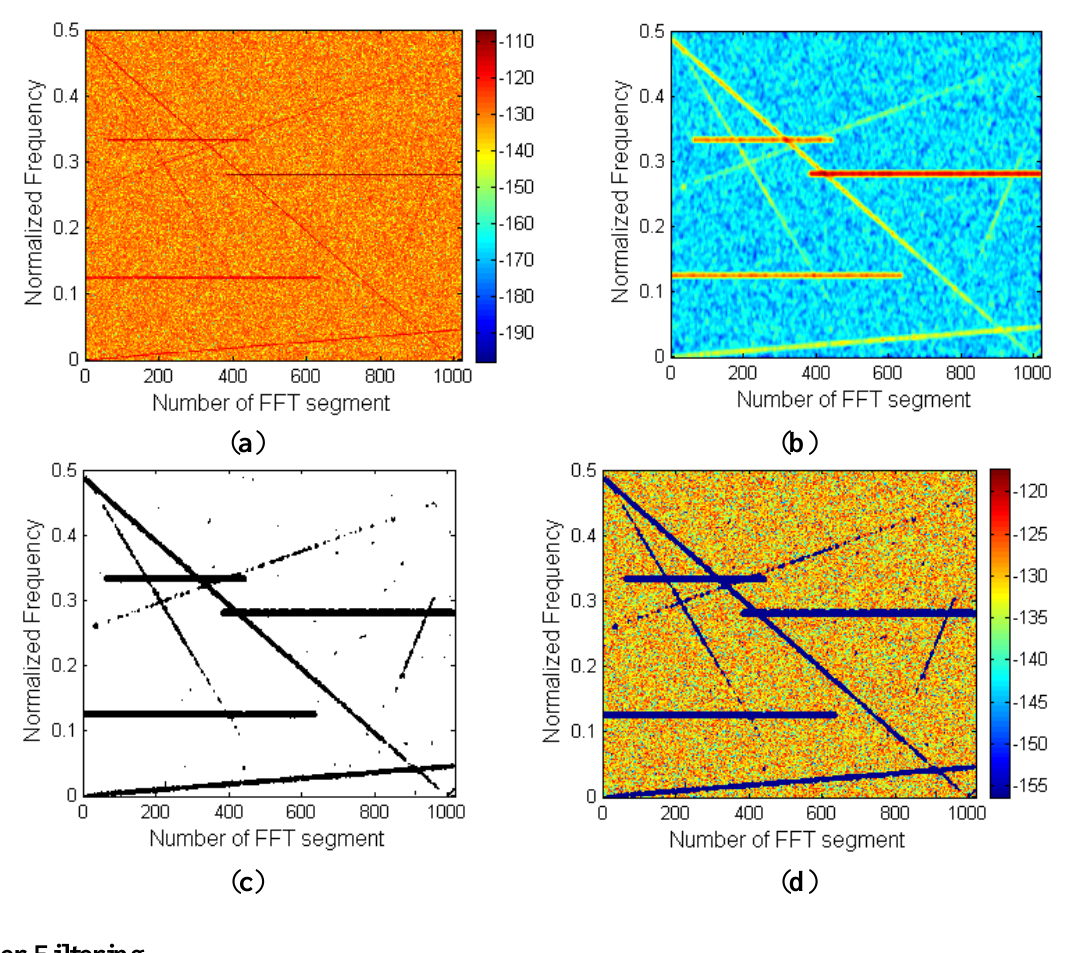
Figure 4. Smoothing Algorithm applied to a simulated Radio Frequency Interference (RFI) contaminated radiometric signal. ( a ) RFI contaminated signal’s spectrogram, σ 2 = σ 2 – 5 dB; ( b ) Convolution of the spectrogram with a N × N = 15 × 15 Hann RFI n